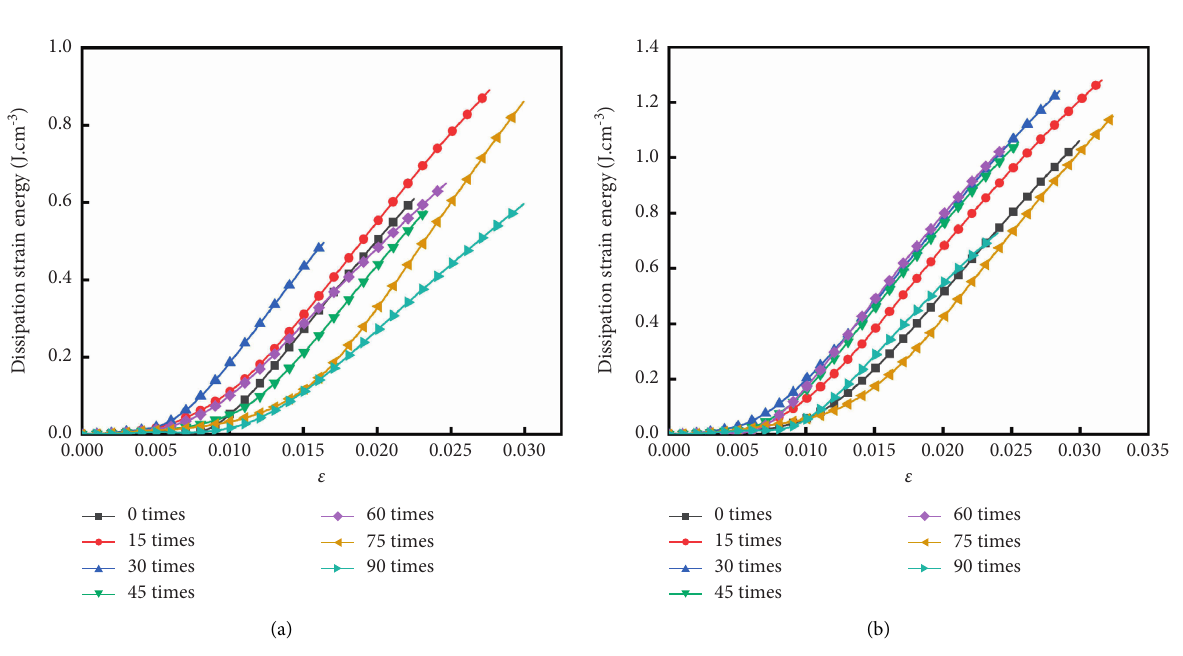
Figure 6: Dissipation strain energy. (a) NC. (b)